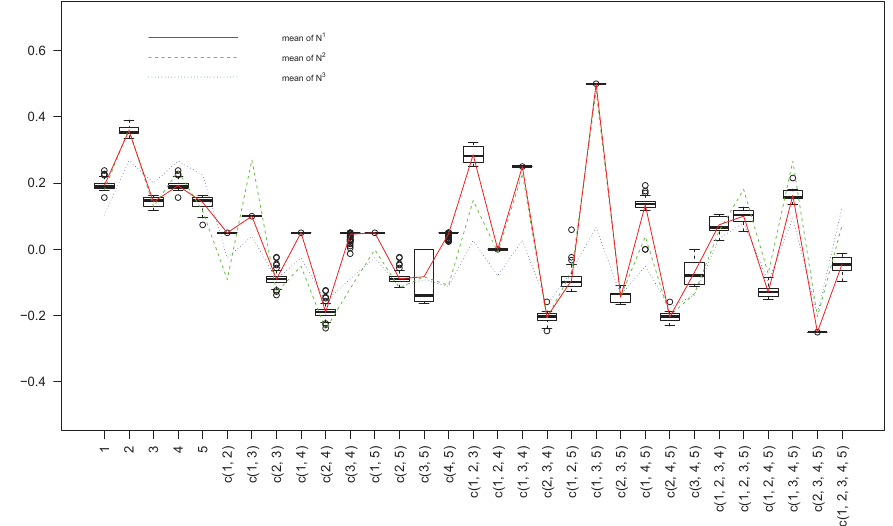
Figure 1. The nonadditivity index matrix N 1 by Algorithm